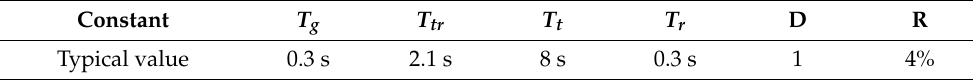
Table 3. Parameter values for the simplified KSA